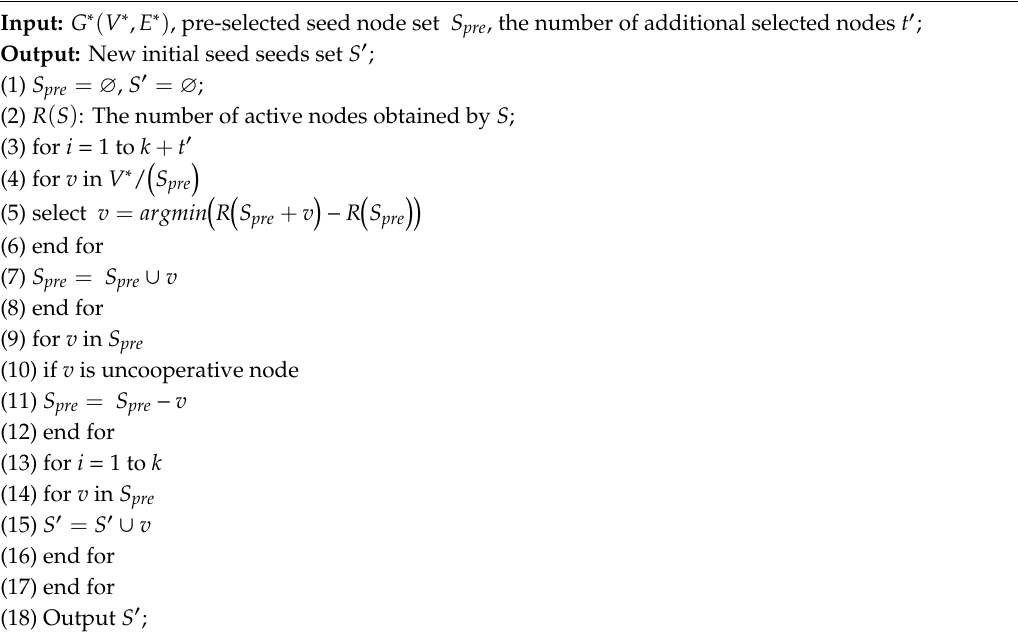
Algorithm 3. Pre-selected-based Substitutes Mining Algorithm for SMMNIM